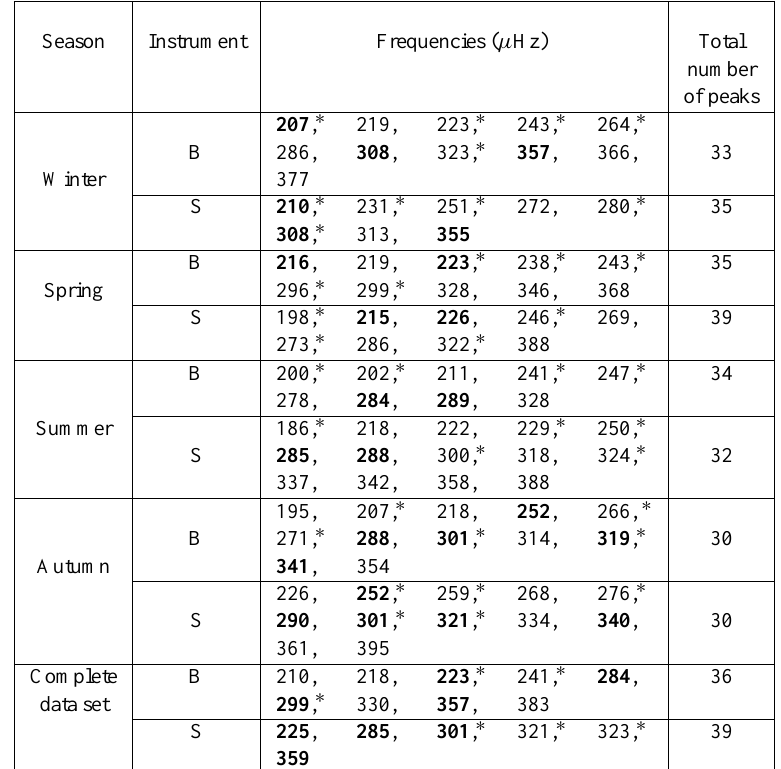
Table 2. Frequencies of oscillations in the 42 − 90-min period subrange, measured by microbarograph (B) and seisomograph (S) at St.Petersburg (60 ◦ N, 30 ◦ E). Table shows the oscillations which exceed the 10% probability level (see Appendix). Close frequencies observed by both instruments are shown as bold-faced numbers